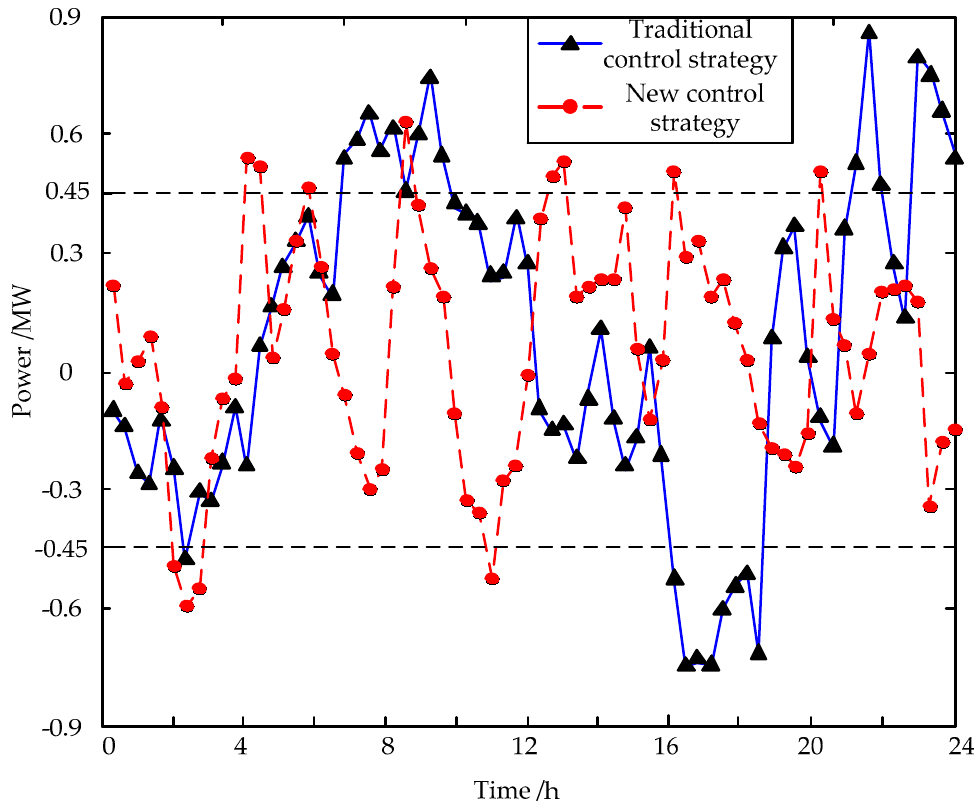
Figure 10. Unit combined power fluctuation under two control strategies.